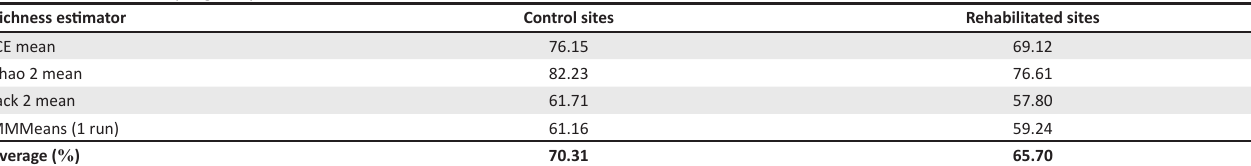
TABLE 5-A4: Overall sampling completeness. Richness